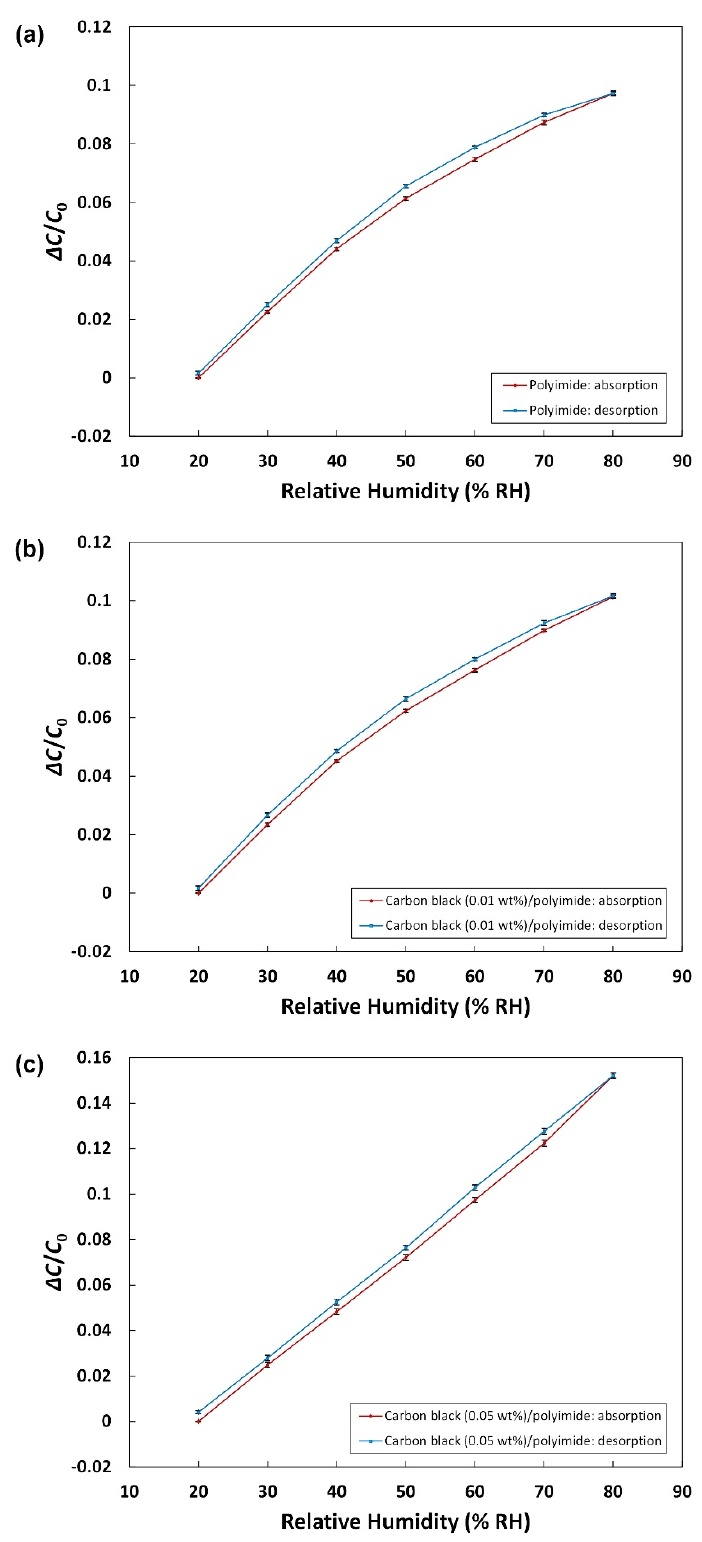
Figure 5. Hysteresis characteristics of the humidity sensors with ( a ) pure polyimide, ( b ) carbon black (0.01 wt%)/polyimide, and ( c ) carbon black (0.05 wt%)/polyimide.